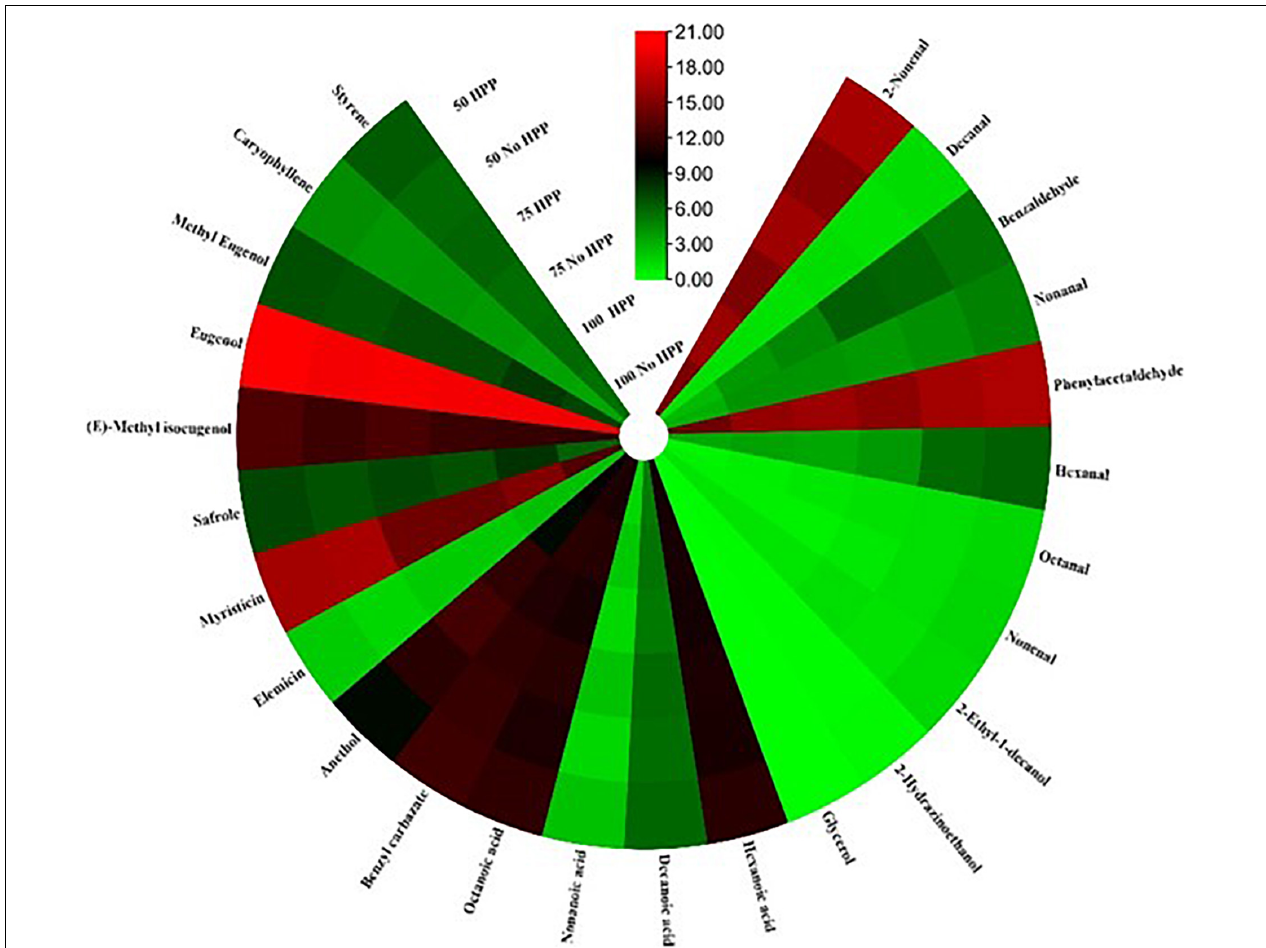
FIGURE 6 | Heat map of odor activity values (OAVs) of volatile compounds in sausage stored at 7 days. The color scale indicates the intensity of the OAV.